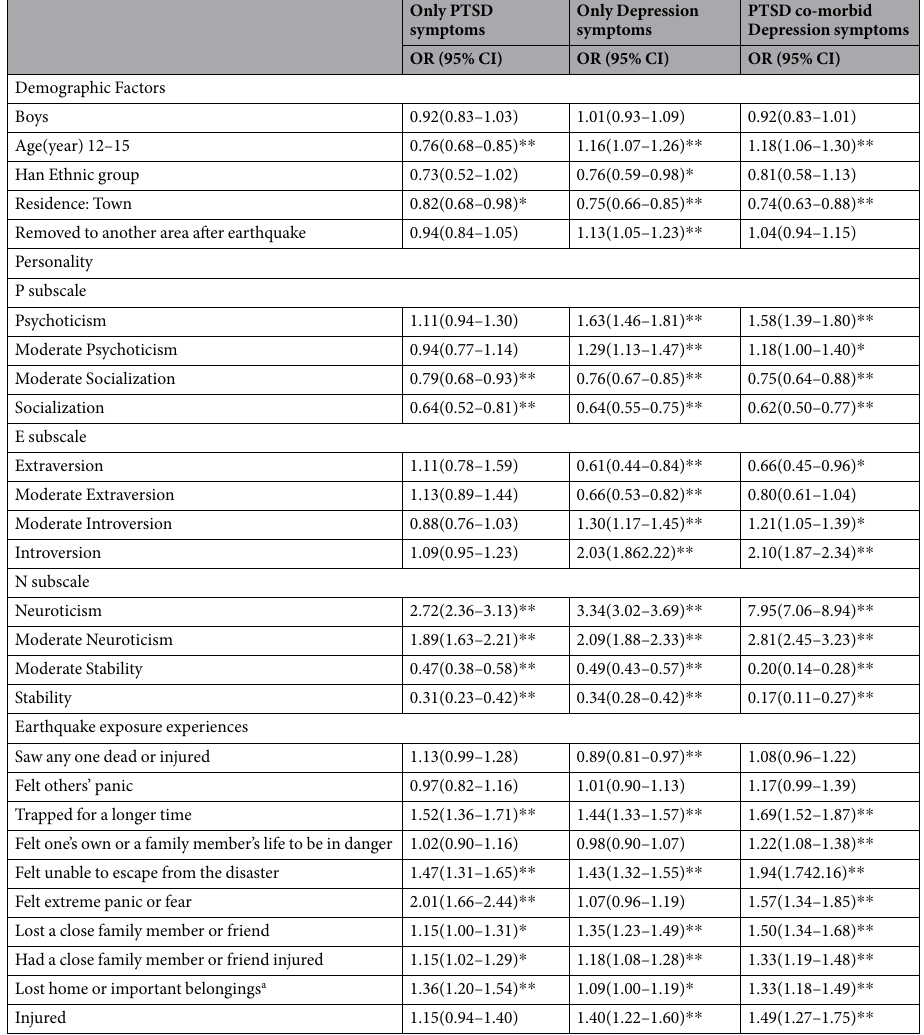
Table 3. Multinomial Logistic Analysis of Risk factors for Children with PTSD, Depression and PTSD co- morbid Depression Symptoms Following Wenchuan earthquake—Qingchuan. * P < 0.05, ** P < 0.01; OR, odds ratio; CI, confidence